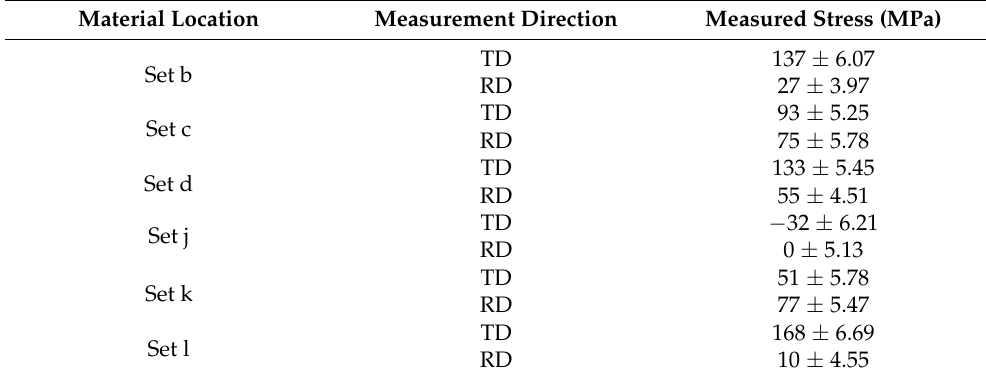
Table 5. XRD measurement results.